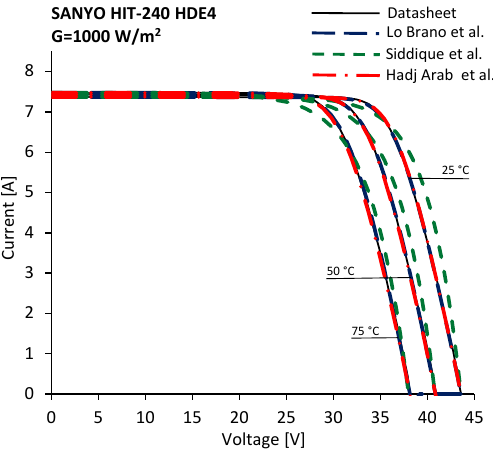
Figure 15. Comparison between the issued I-V characteristics of Sanyo HIT-240 HDE4 at G = 1000 W/m 2 and the characteristics calculated by means of the Lo Brano et al ., the Siddique et al . and the Hadj Arab et al . models.